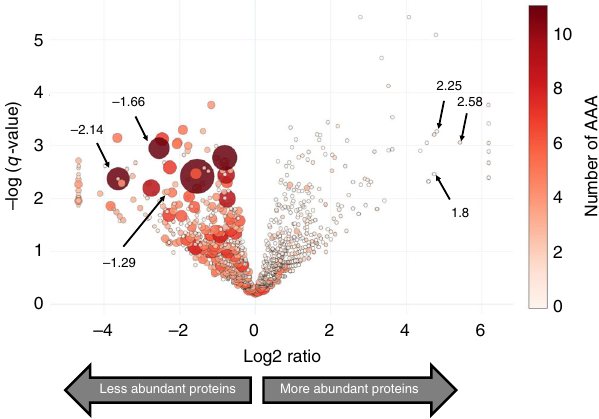
Fig. 6 Induction of MazF-mt9 leads to global proteomic shifts based on the AAA codon content of transcripts. Volcano plot showing the proteomic changes in newly synthesized proteins between induced ( + MazF-mt9) and uninduced cells. The diameter and color intensity of each represented protein (circle) is proportional to the number of AAA codons in its coding sequence. Fold changes in mRNA levels obtained by RNA-seq are shown for three examples of upregulated and downregulated proteins (arrows). The source data with full list of detected proteins is presented